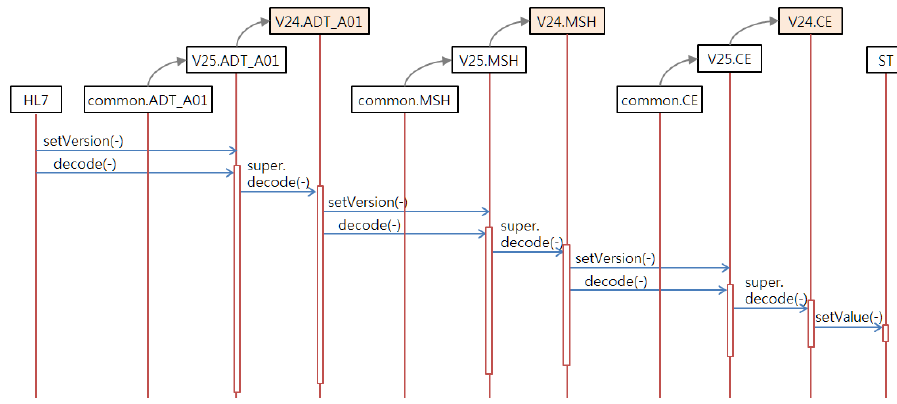
Fig. 6. Method diagram for decoding of an